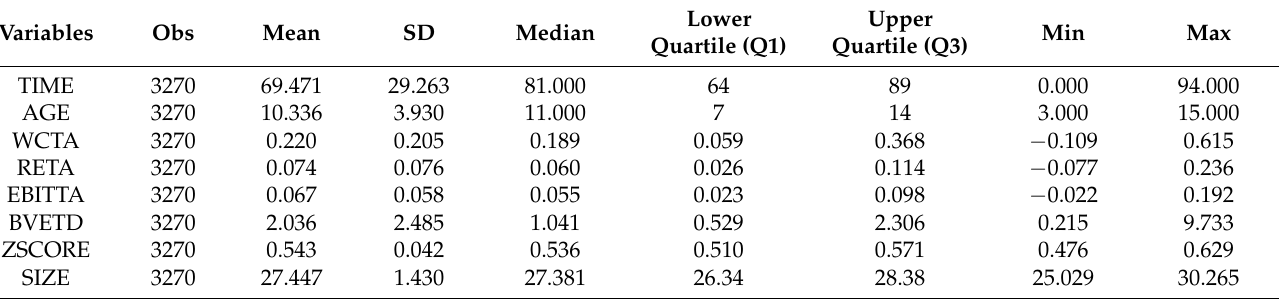
Table 2. Summary of statistics of variables.